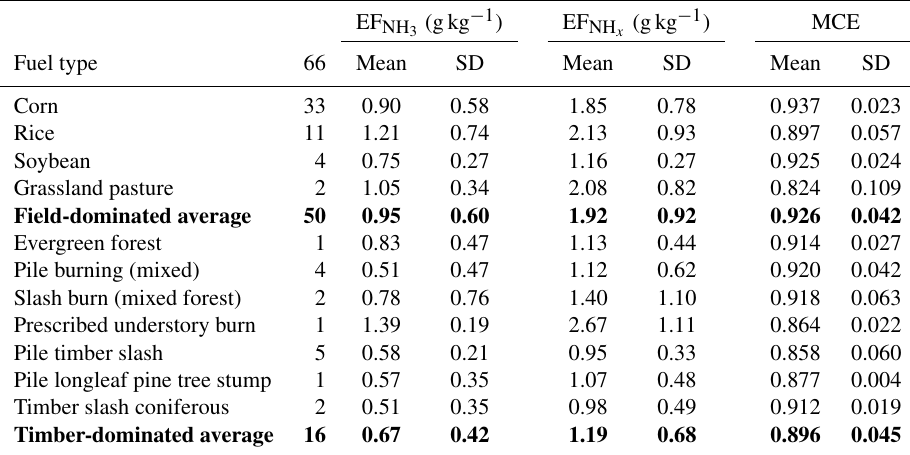
(as measured for six wildfires in the Western United States during FIREX-AQ and obtained from two Figure 6. Scatter plot of EF NH 3 literature sources) vs. MCE. , EF NH and MCE as measured during FIREX-AQ for small agricultural fires in the Southeastern United States burning on Table 2. EF NH x 3 different types of fuel. The lines in bold are average values of the above-listed data for field-dominated fuels and timber-dominated fuels,